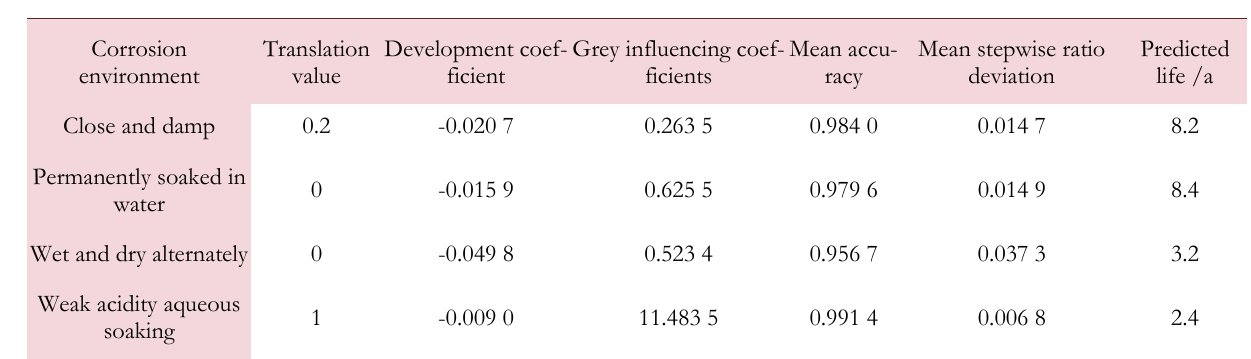
Table 3: Feasibility verification of grey prediction.